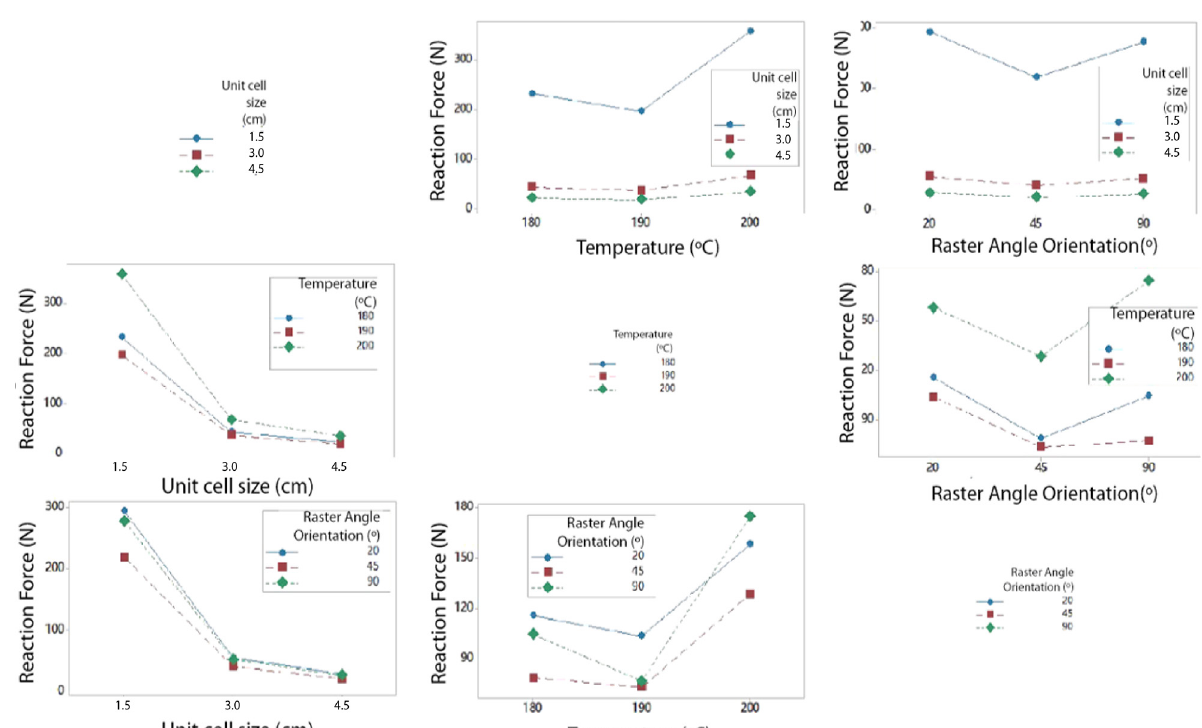
Figure B3. Interaction graph for FCC. Figure A4. Interaction graph for FCC.